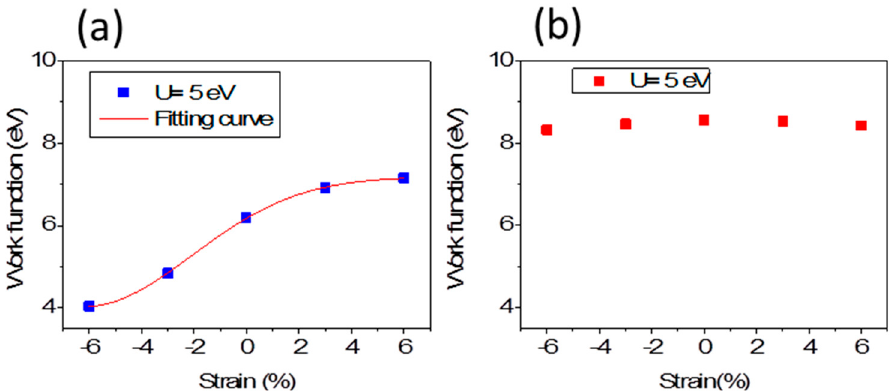
Figure 4. The work function of Fe terminated α -Fe 2 O 3 1 × 1 × 3 film ( a ); and O terminated α -Fe 2 O 3 1 × 1 × 3 film as a function of strain ( b ).